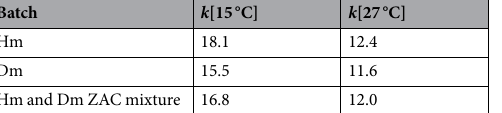
Table 4. Summary of the results from capillary viscometry of the different particles and the resulting shift factors k used to determine the effective volume fraction φ eff through φ eff = kC , C is the microgel weight